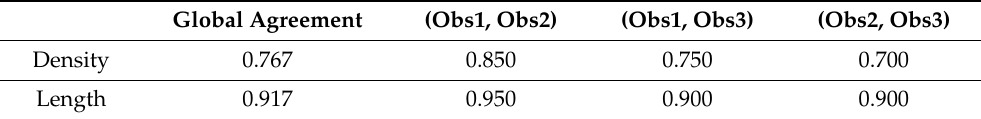
Table 1. Analysis of the obturation length, density, and quality parameters. Table 2. Inter-observer and global agreement.